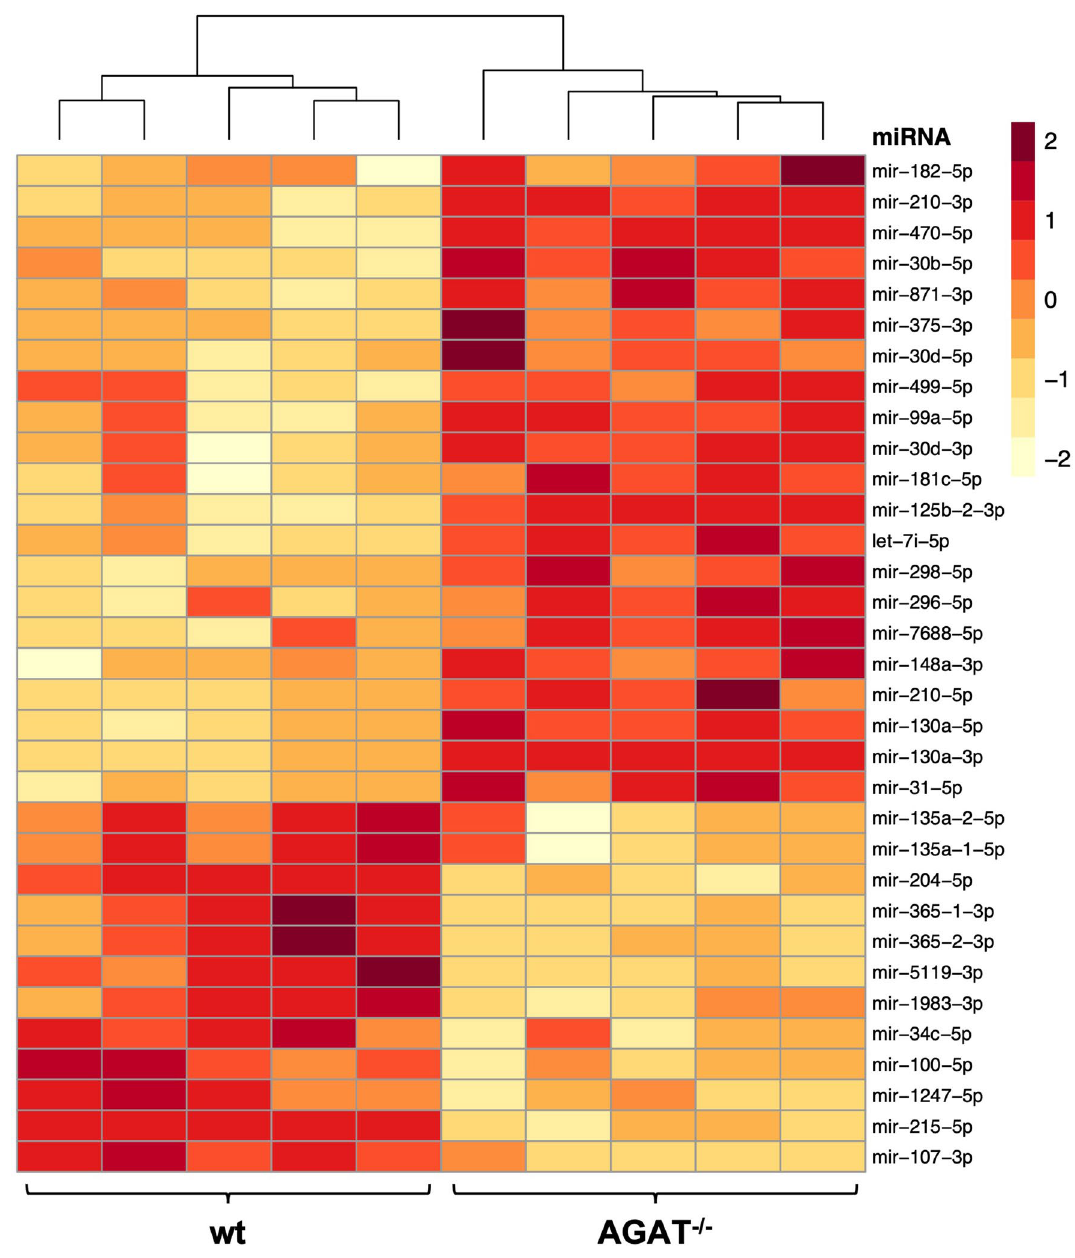
Figure 2. Significantly regulated miRNAs between wt and AGAT -/- mice. Z score transformed heat map of miRNA sequencing results on AGAT -/- in comparison with wt mice (n = 5 per group). Low to high expression is represented by a change of color from yellow to red. 3p and 5p indicates the origin of the miRNA from the 3’ arm or 5’ arm, respectively. Significance level: False Discovery Rate (FDR) ≤ 0.05. wt: wild type; AGAT -/- : AGAT knockout.